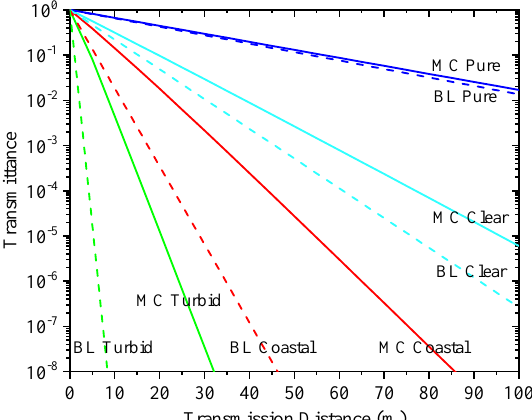
Figure 1. Schematic diagram of an underwater CVQKD system. The sender Alice separates coherent light pulses generated by a laser diode into weak signal pulses and strong LO pulses. Then the signal pulses are loaded with key information by using an amplitude modulator and a phase modulator, and the LO pulses are delayed by a delay line so as to be transmitted together with the signal pulses through time multiplexing. After being transmitted through the seawater, the pulses reach Bob’s telescope. Bob first separates the LO and signal pulses by using a beam splitter, and then randomly measures one of the quadratures of the signal states by homodyne detection, with the help of the LO as a phase reference. The phase modulator in Bob is used to randomly select the quadrature by imposing a π /2 phase shift to the LO. The dark spots between Alice and Bob indicate the water components such as phytoplankton, suspended sediments and detritus, and colored dissolved organic matter. AM: amplitude modulator. PM: phase modulator. Tele.: telescope. BS: beam splitter. PD: photodiode. LO: local oscillator.